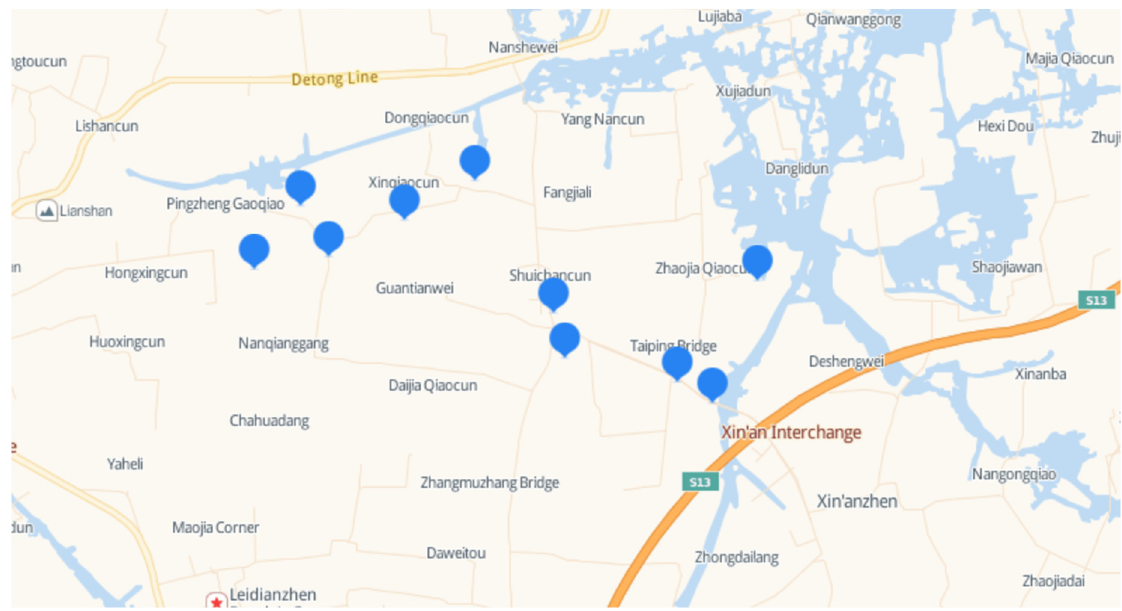
Figure 2. Collection sites of drinking water.